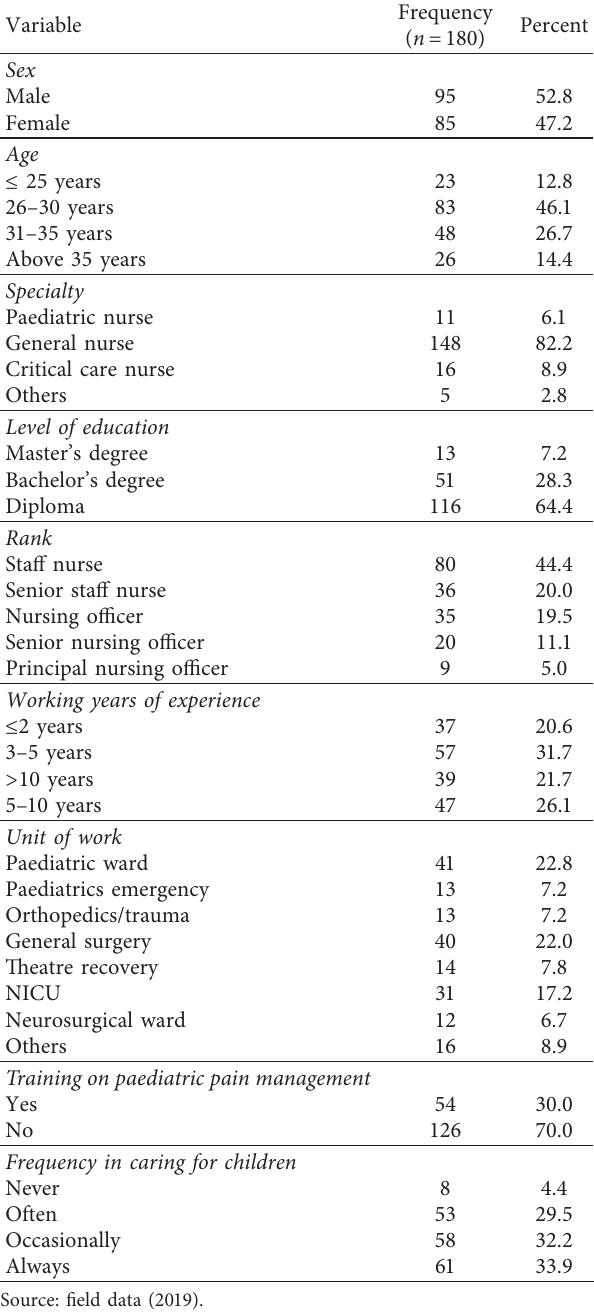
Table 1: Sociodemographic characteristics of